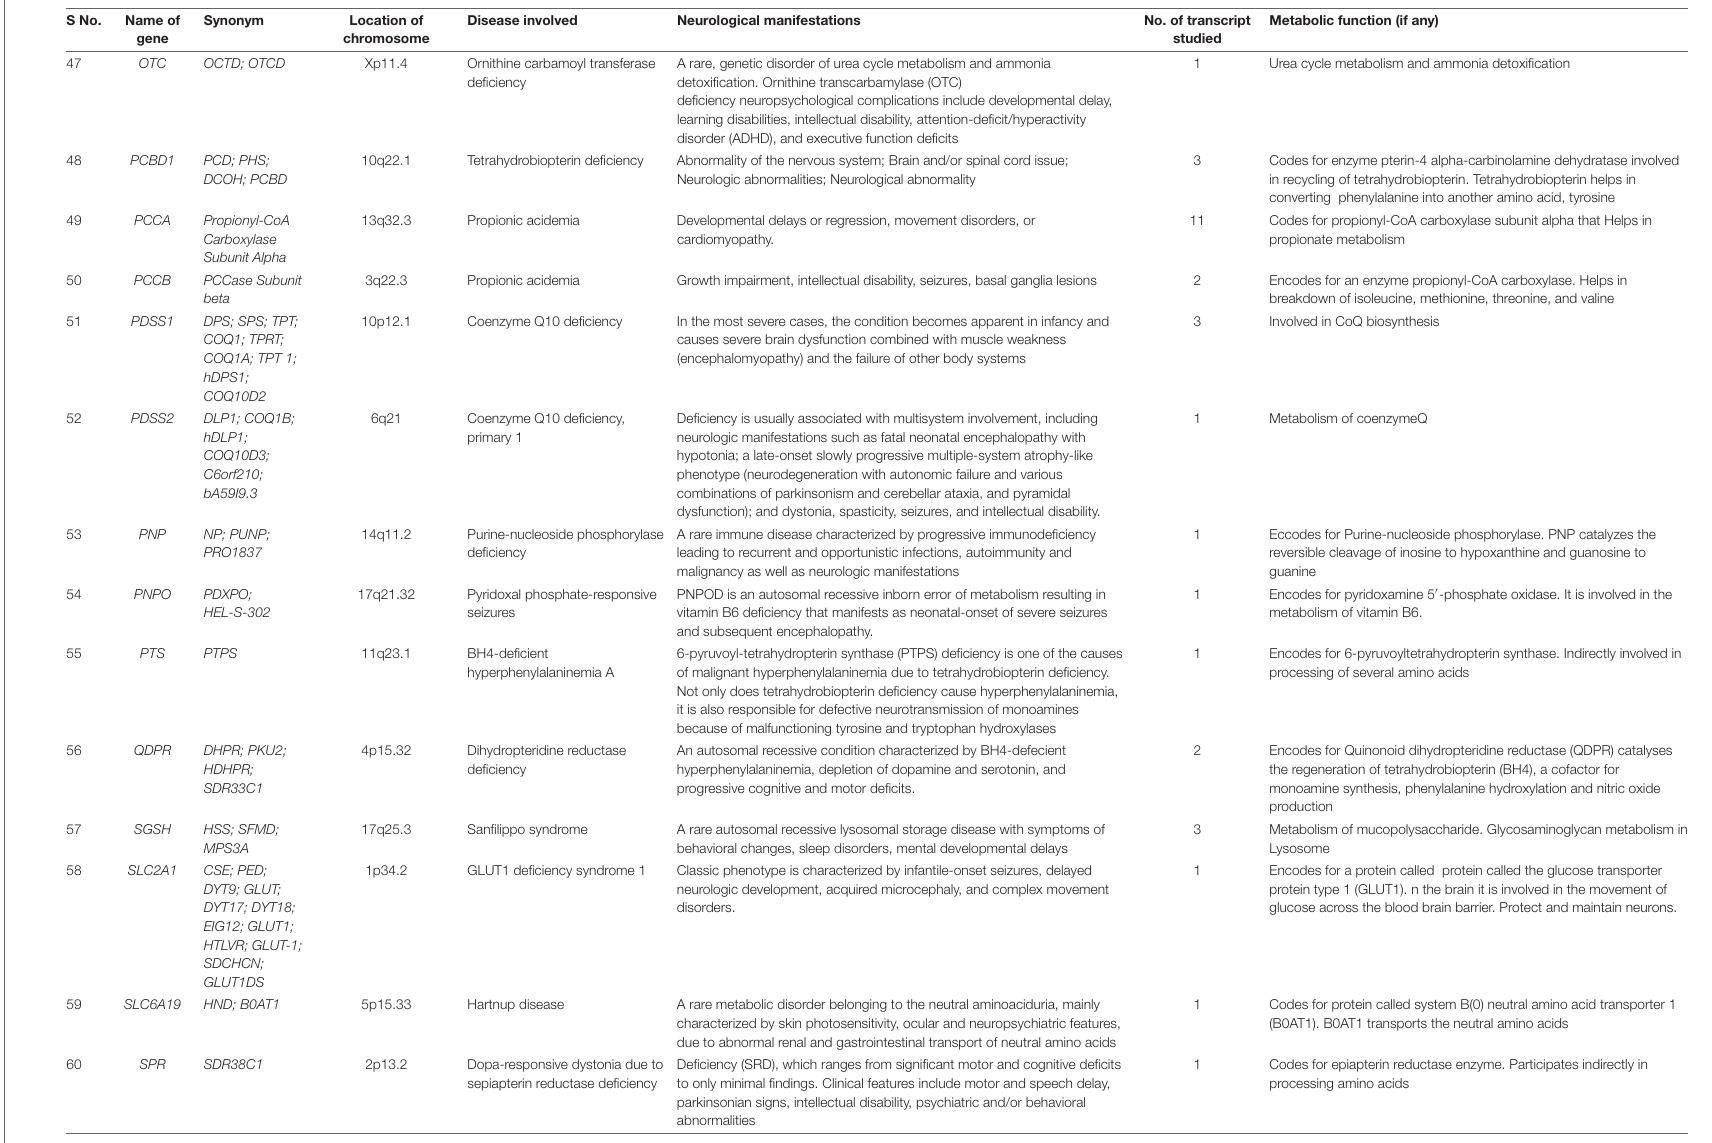
Codes for epiapterin reductase enzyme. Participates indirectly in processing amino